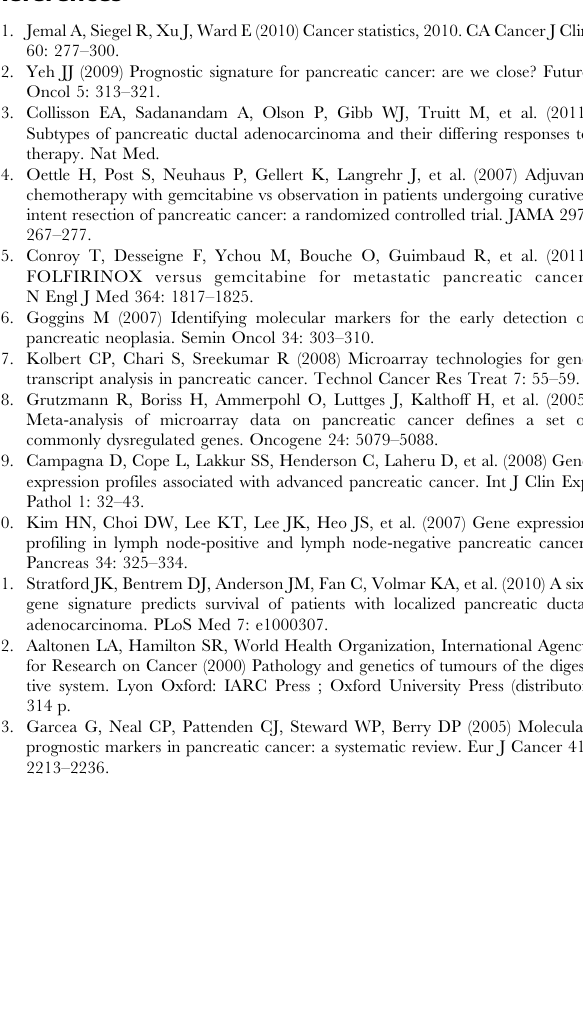
Table S1 A list of 36 genes selected from microarray analysis and evaluated by RT-PCR in Germany test cohort. Table S2 Correlation of histological grade, stage or resection margin with DPEP1 or TPX2 gene